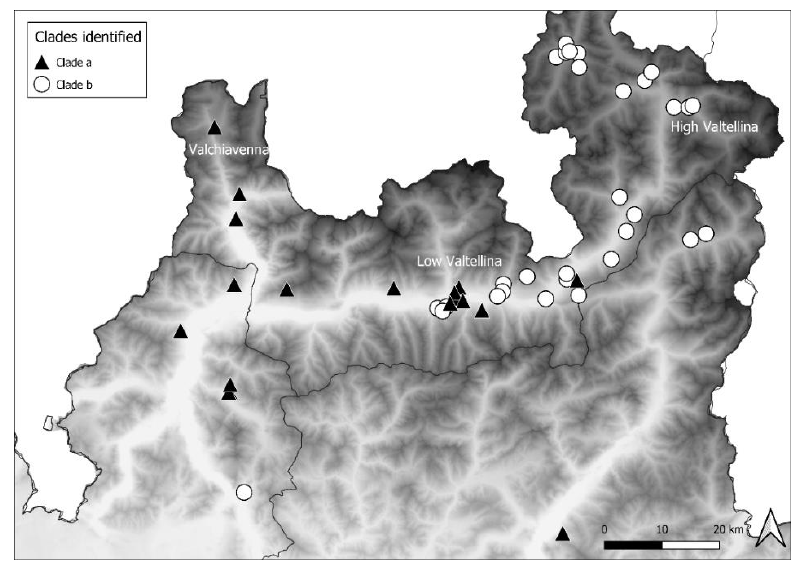
8 of 13 Figure 3. Maximum-likelihood phylogenetic tree based on the partial sequencing of the H gene. Italian CDV sequences investigated in this study are reported in bold. Reference CDV sequences are named, including the genBank accession number, the name of the strain, the host, and the country of origin. Boostrap values are indicated next to nodes. The distribution of clade a mostly extended up to the western part of Area 3 and in